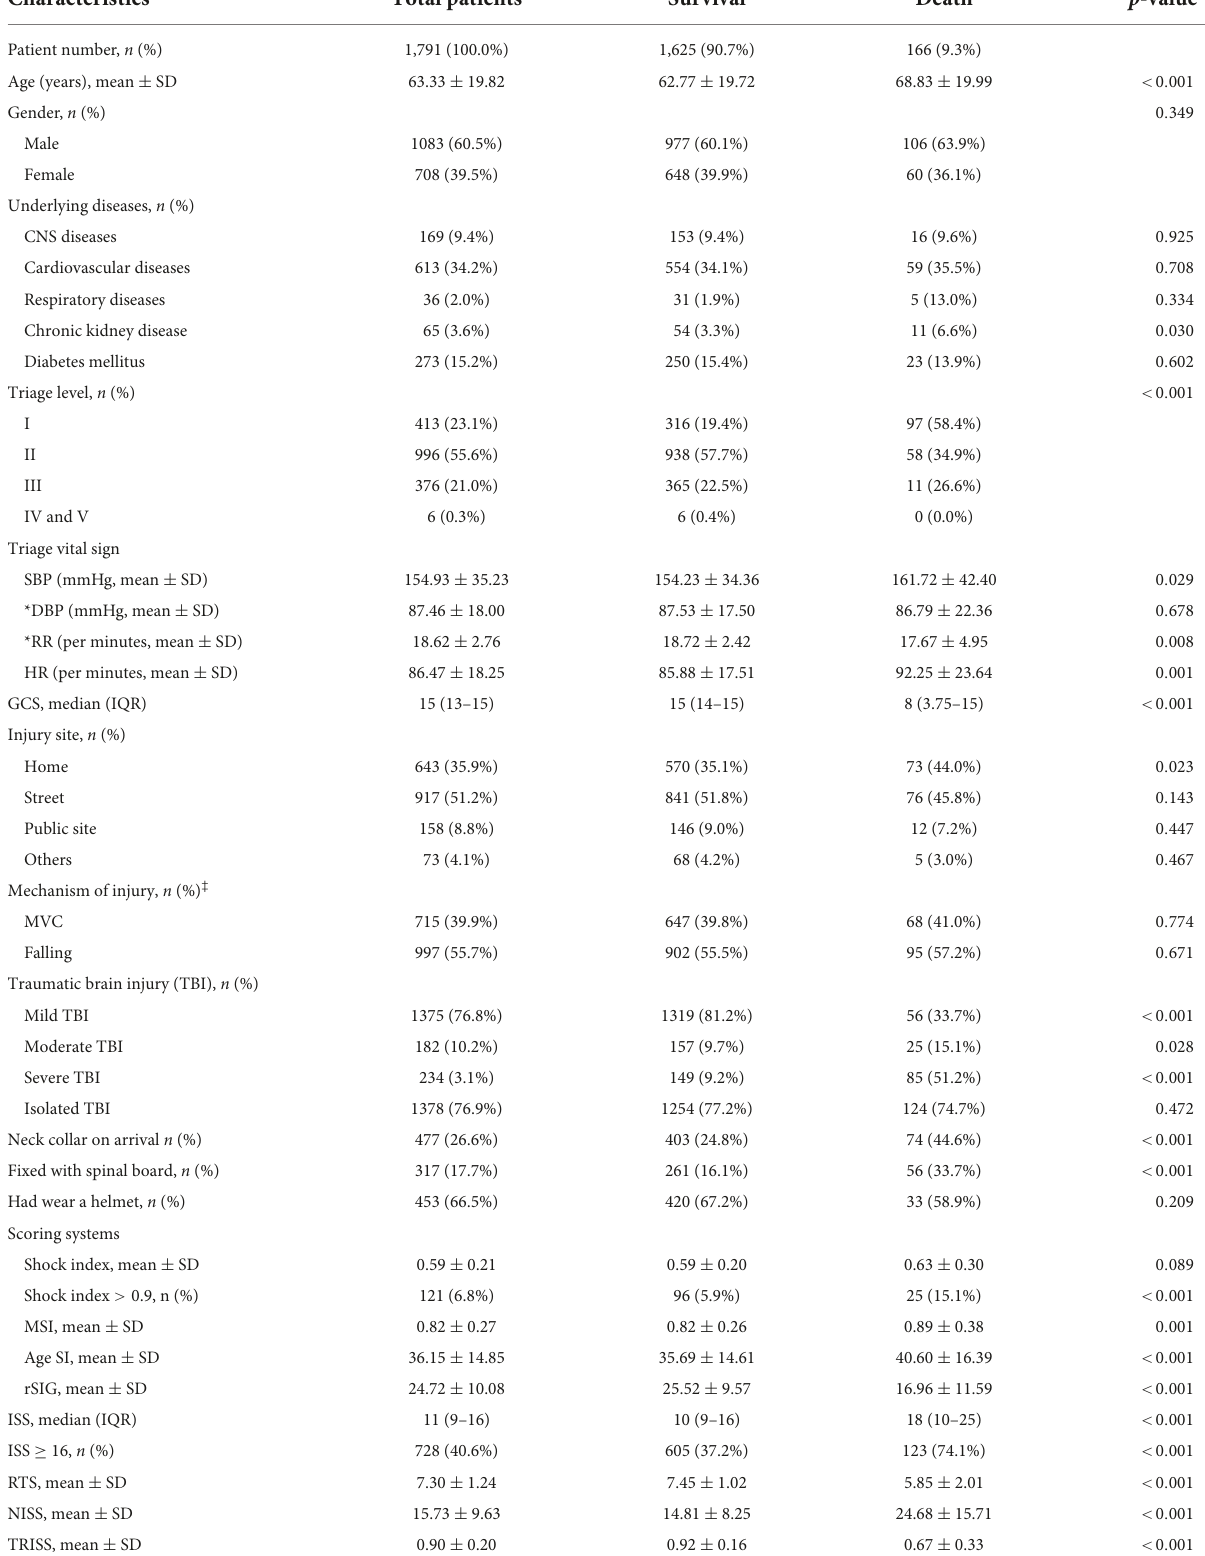
TABLE 1 Demographics of the traumatic brain injury population.